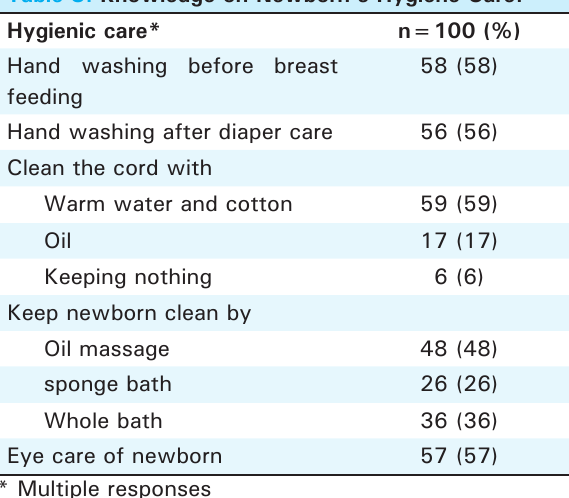
Table 10. Practice on Successful Breast